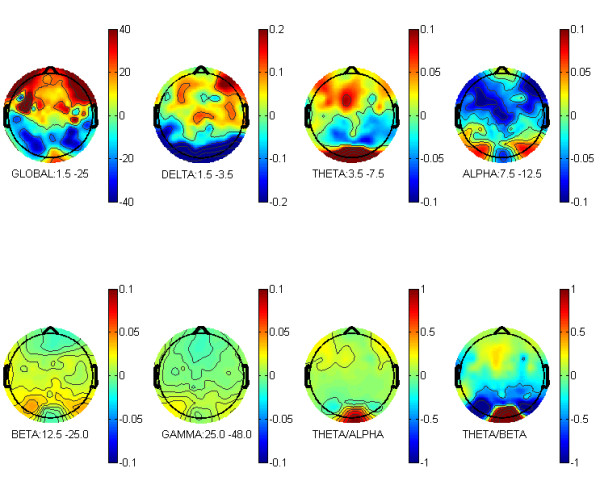
Difference of global power – MPH minus Placebo. The difference of the grand average global and relative power (delta, theta, alpha, beta, and gamma) between the MPH condition and the placebo condition calculated over the 35 subjects. It can clearly be seen that the global power is strongest over frontal regions (global power is given in ft/vHz. Delta, Theta, Alpha, Beta and Gamma are relative measures, normalized to the Global power. Theta/Alpha and Theta/Beta are ratios of the relative power, which is identical to ratios of the power).